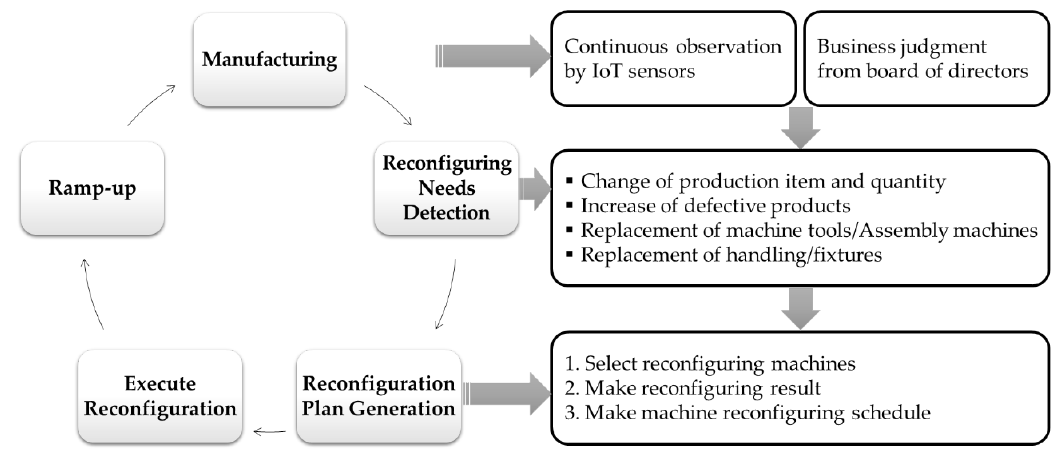
Figure 4. Reconfiguration process of the RMS.